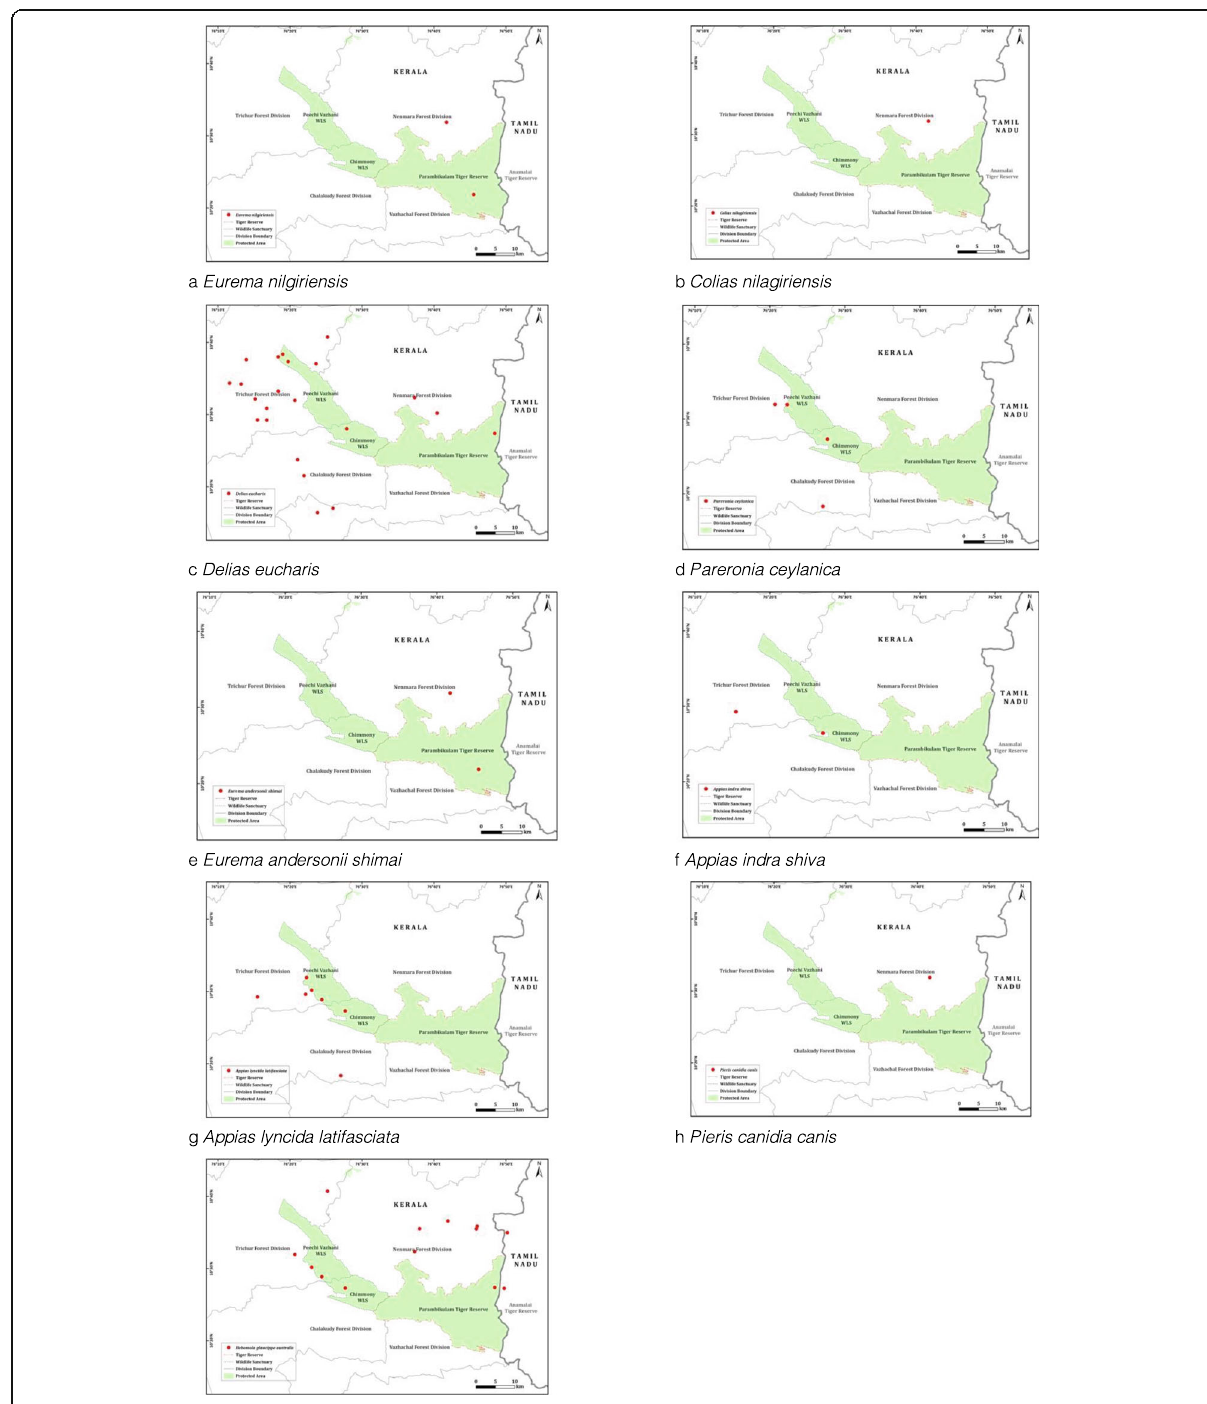
Fig. 4 a - i Distribution maps of endemic butterflies of family Pieridae within study area. a Eurema nilgiriensis . b Colias nilagiriensis . c Delias eucharis . d Pareronia ceylanica . e Eurema andersonii shimai . f Appias indra shiva . g Appias lyncida latifasciata . h Pieris canidia canis . i Hebomoia glaucippe